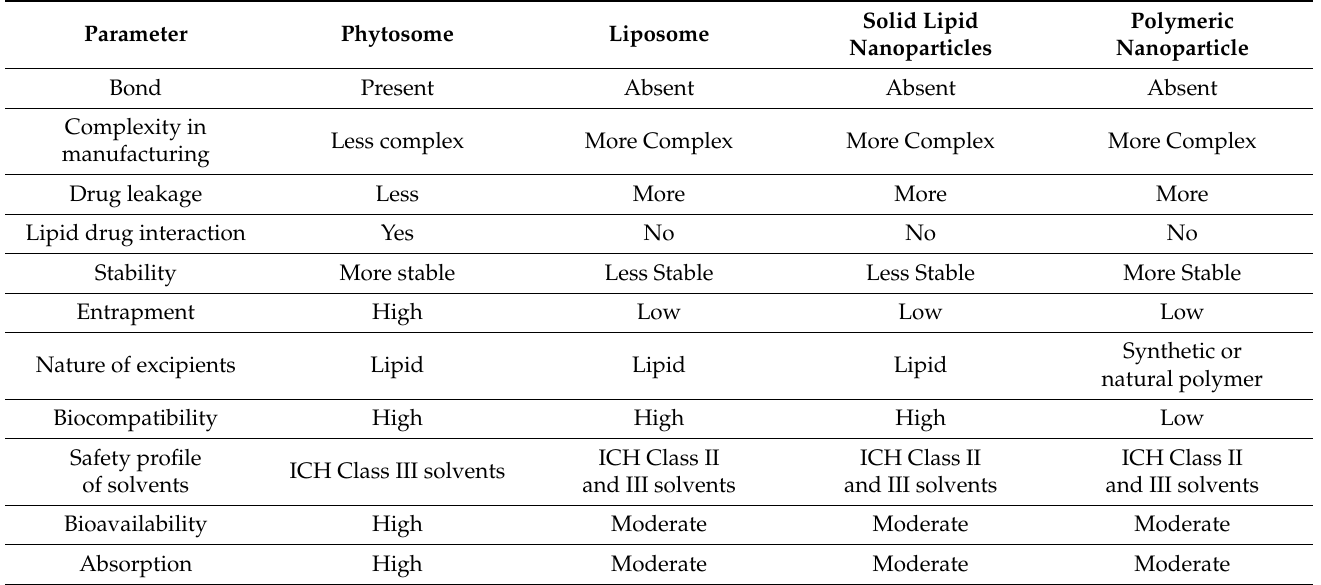
Figure 3. Types of colloidal drug delivery systems. Table 2. Distinguishing features among different types of colloidal nano ‐ carriers.